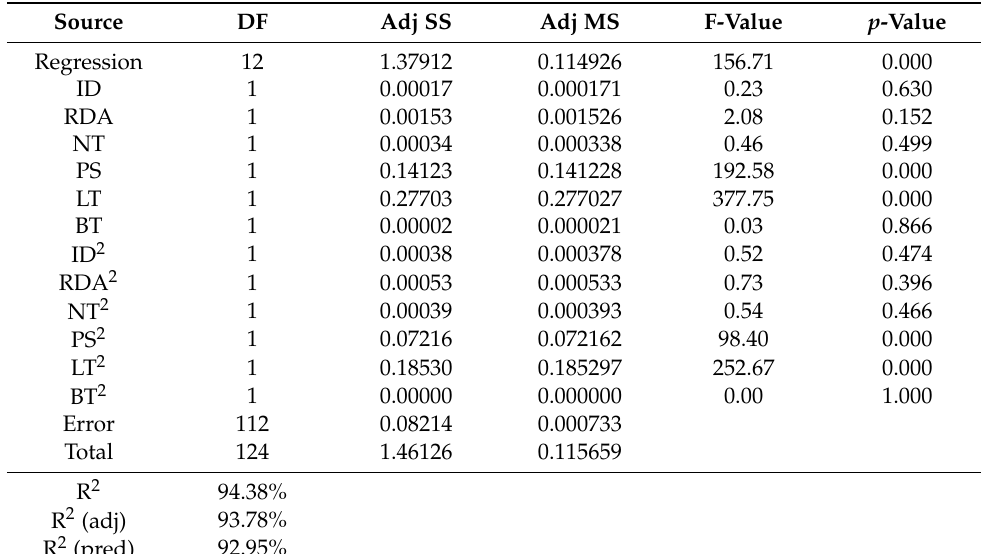
Table 7. Polynomial ANOVA, EPC vs. ID, RDA, NT, PS, LT,